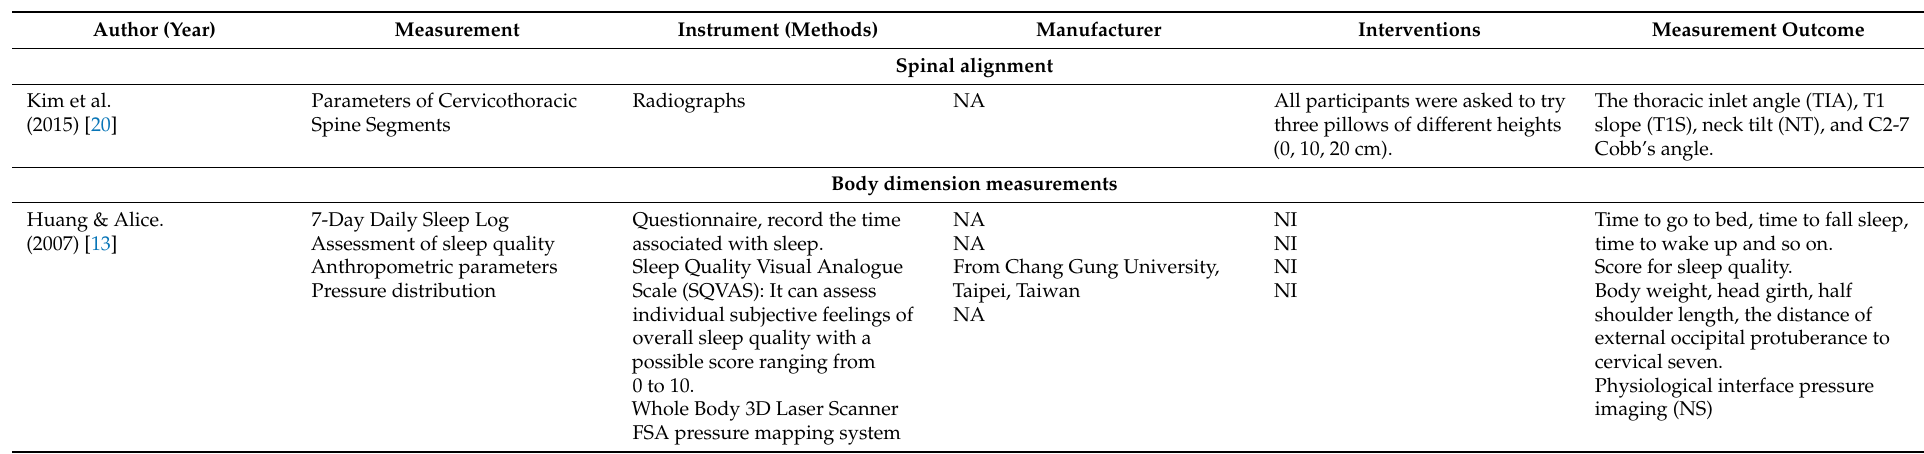
Table 2. Measurement methods and outcomes of parameters in the reviewed